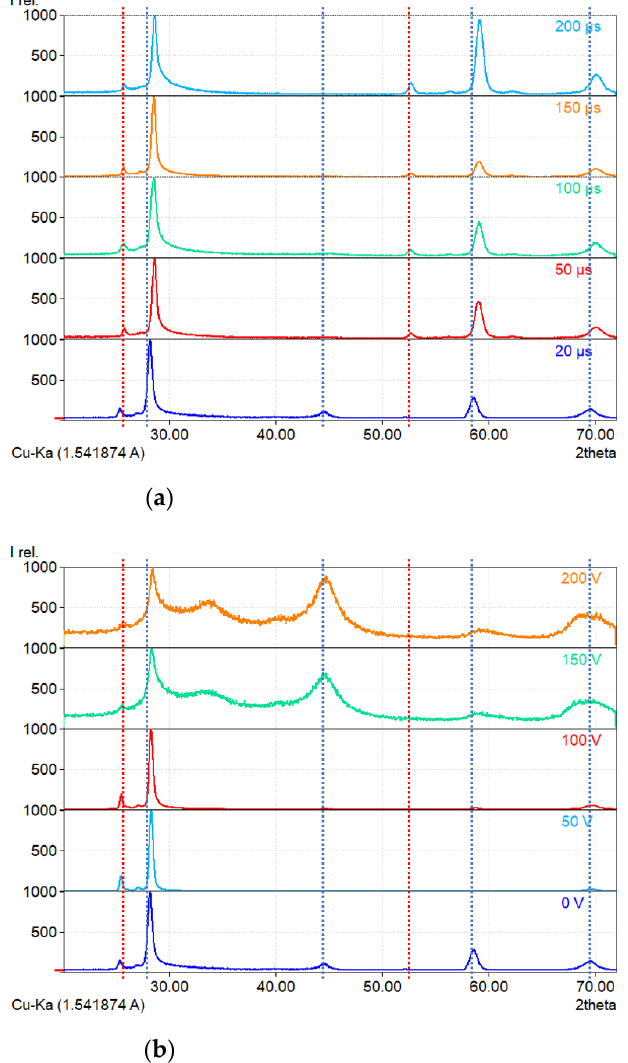
Figure 1. X-ray diffraction patterns of coatings deposited with ( a ) different pulse durations and ( b ) different bias voltages. WB 2 – P6/mmm marked with blue dashed line, WB 2 – P63/mmc marked with a red dashed line.